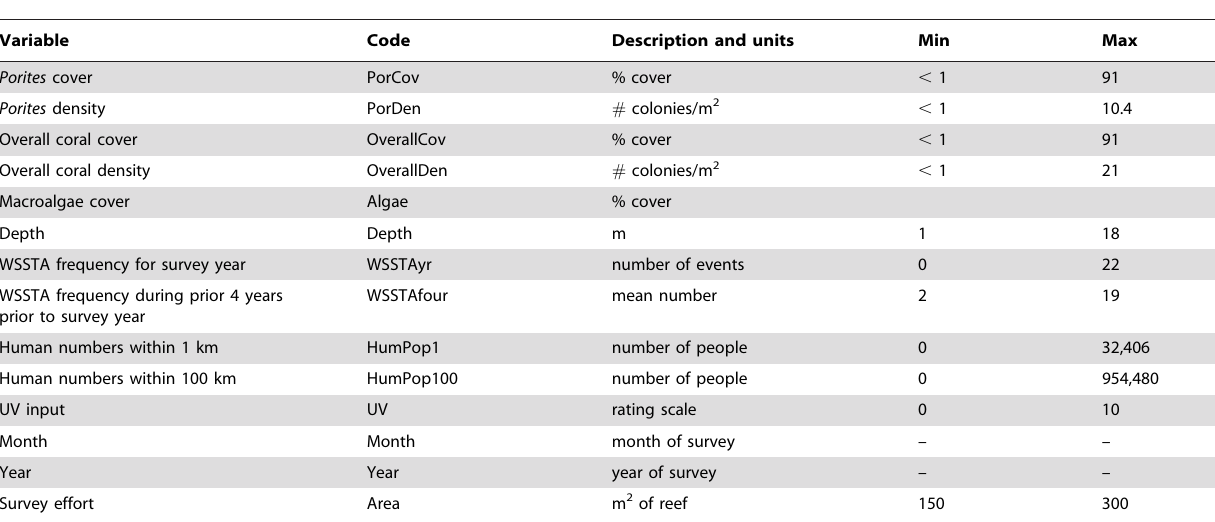
Table 2. Predictor variables used in the modeling analyses with their codes and units.